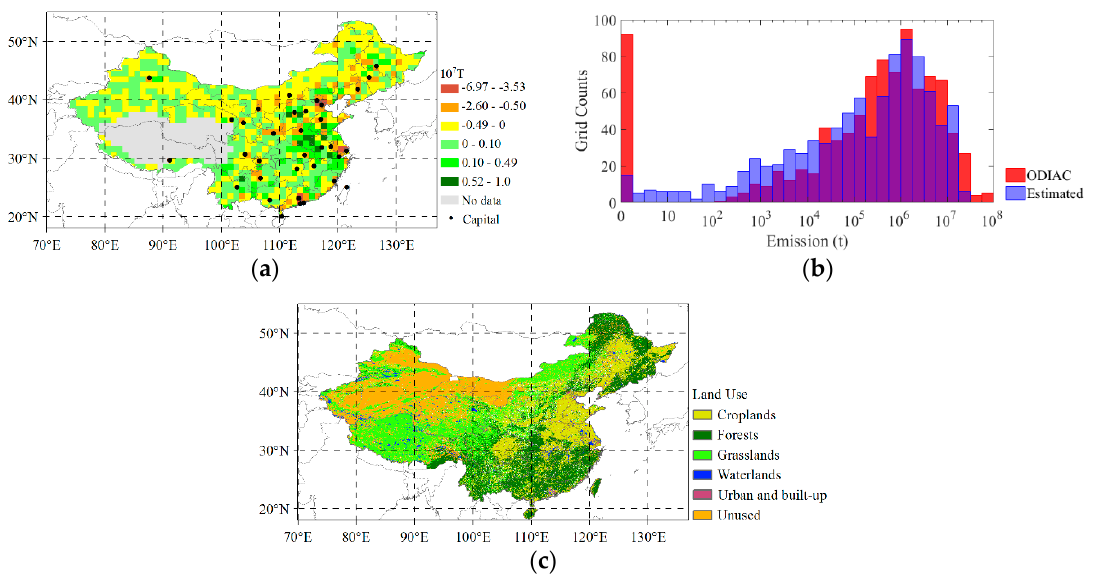
Figure 5. ( a ) The difference between the estimated CO 2 emission using mapping-XCO 2 in 2015 and ODIAC emission in 2015; ( b ) Histogram comparison of the estimated and the ODIAC CO 2 emission (in unit of Ton/year) in 2015; ( c ) Land use of China in 2010.